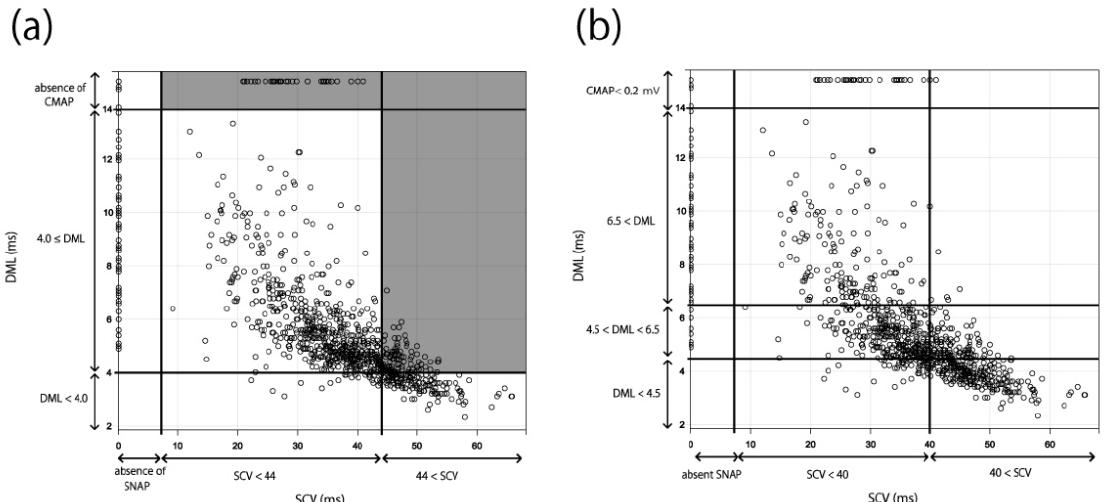
Figure 5. Results applied to the existing classifications. The NCS results of 1120 cases were applied to the existing severity classifications (Figure 1). ( a ) Padua classification: gray areas indicate cases that could not be classified. ( b ) Bland classification. Abbreviations: CMAP, compound muscle action potential; DML, distal motor latency; NCS, nerve conduction study; SCV, sensory nerve conduction velocity; SNAP, sensory nerve action